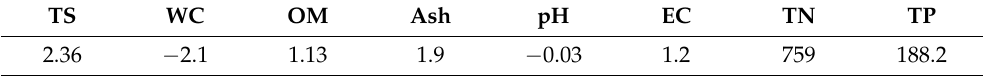
Table 4. Mean differences of physical and chemical properties between RSS and FSS. TS WC OM Ash pH EC TN TP